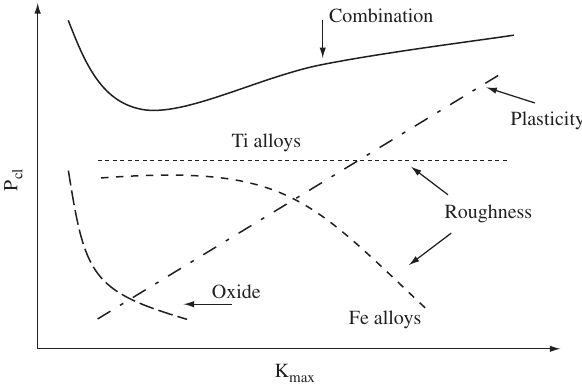
Figure 1. Influence of K on crack closure load for three forms of crack max closure; plasticity-induced crack closure, roughness-induced crack closure, and oxide-induced crack closure as well as their combined influence 7 .